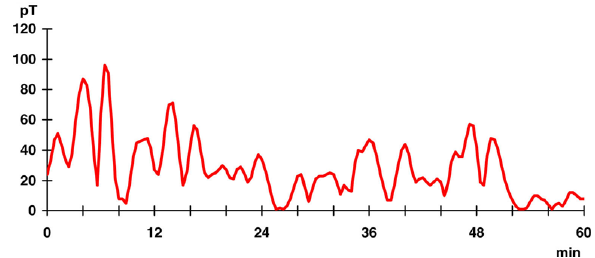
Fig. 2. Average amplitudes of the NCK H component at the local FLR period, 24 s during the eclipse, August 11, 1999, 1000-1100 UT (local time is +1 h).